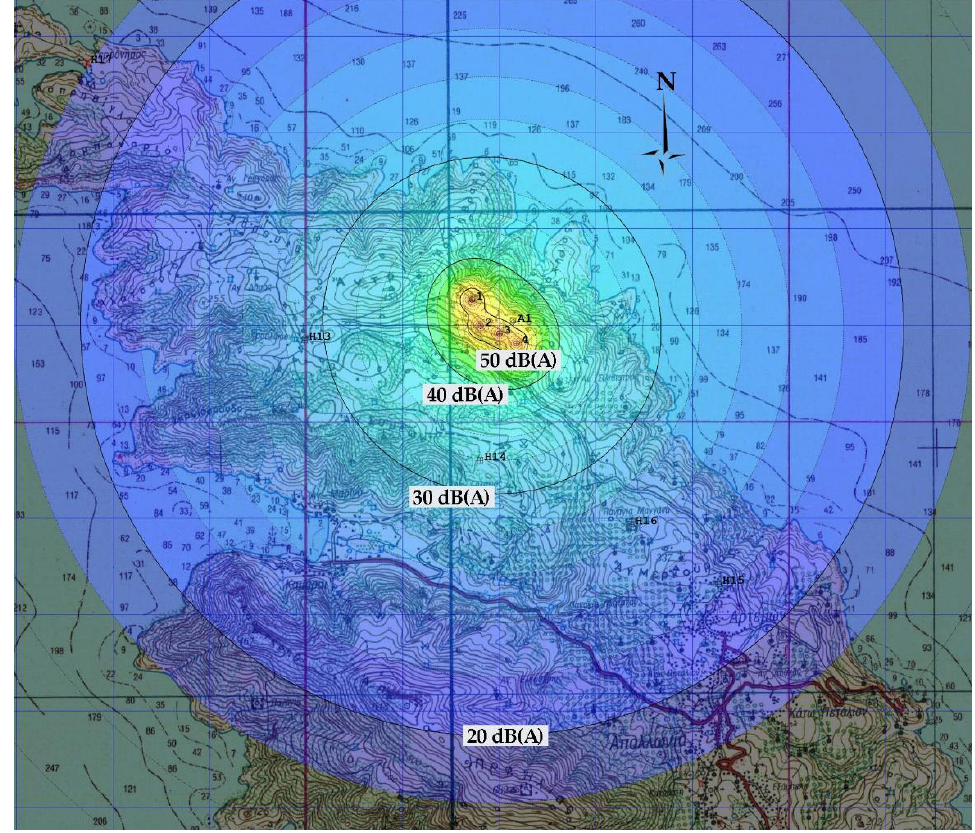
Figure 14. The wind turbines’ aerodynamic noise diffusion map on Sifnos.